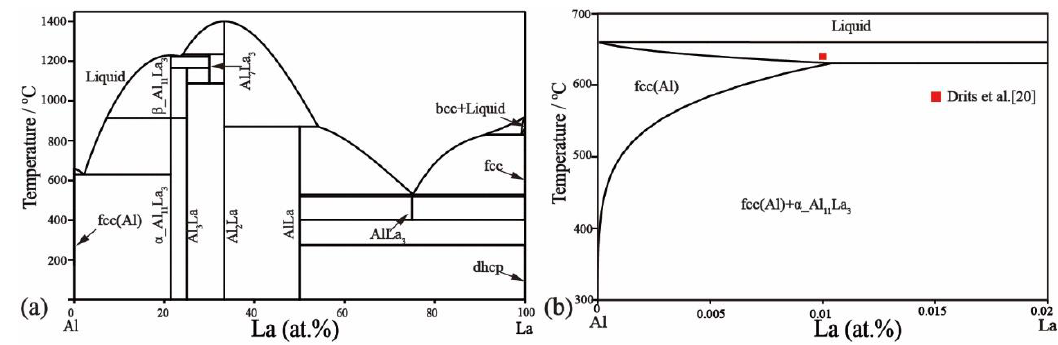
Figure 6. Calculated Ni – La phase diagram. ( a ) Full composition range, ( b ) magnified Ni-rich corner showing solubility of La in fcc(Ni).